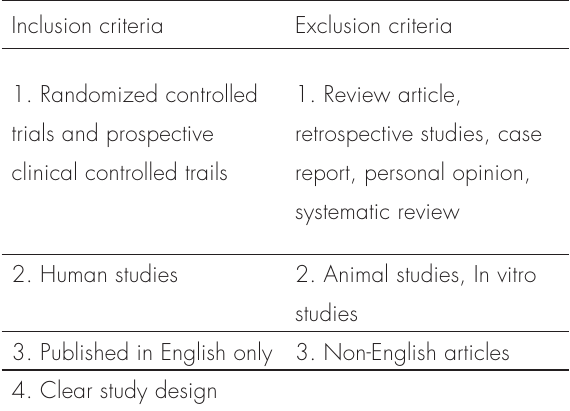
Table II. Inclusion and exclusion criteria. Inclusion